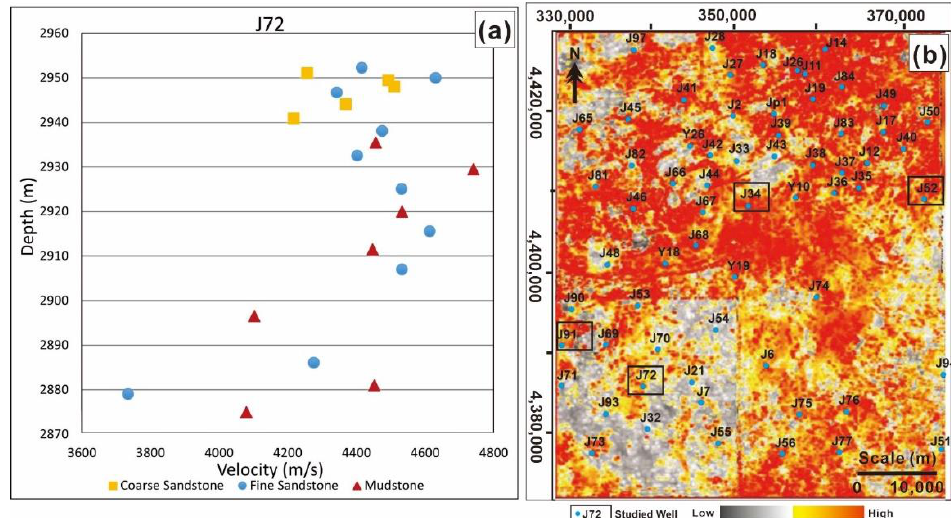
Figure 12. ( a ) Interval velocity distribution to differentiate sandstone and mudstone lithologies. ( b ) RMS horizon attribute map for the member-1 (T9d-T9e) of the LSF.